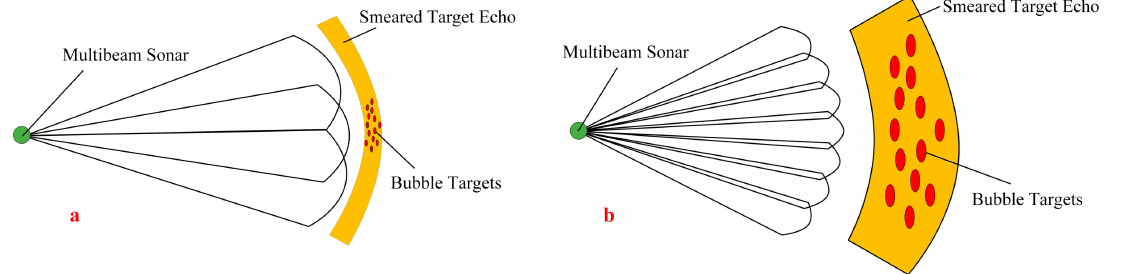
Figure 15. ( a ) Smearing effect at long range. Bubble targets were partially located in three adjacent beams, and the echo trace was smeared over the three beams. ( b ) Smearing effect at short range. Bub- ble targets were located in several beams and partially in the border beams. The target’s echo was smeared across all